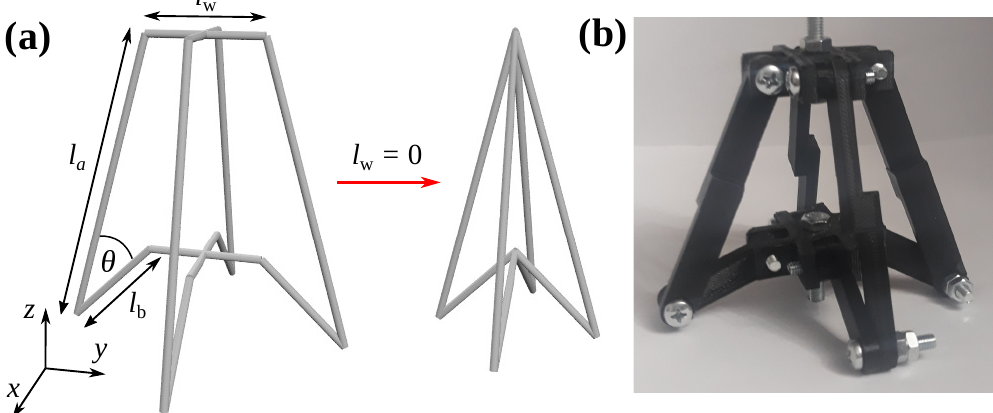
Figure 1. Panels show ( a ) a single unit-cell of the considered model in the case when l w (cid:54) = 0 and l w → 0, and ( b ) an example of the 3D-printed prototype of the